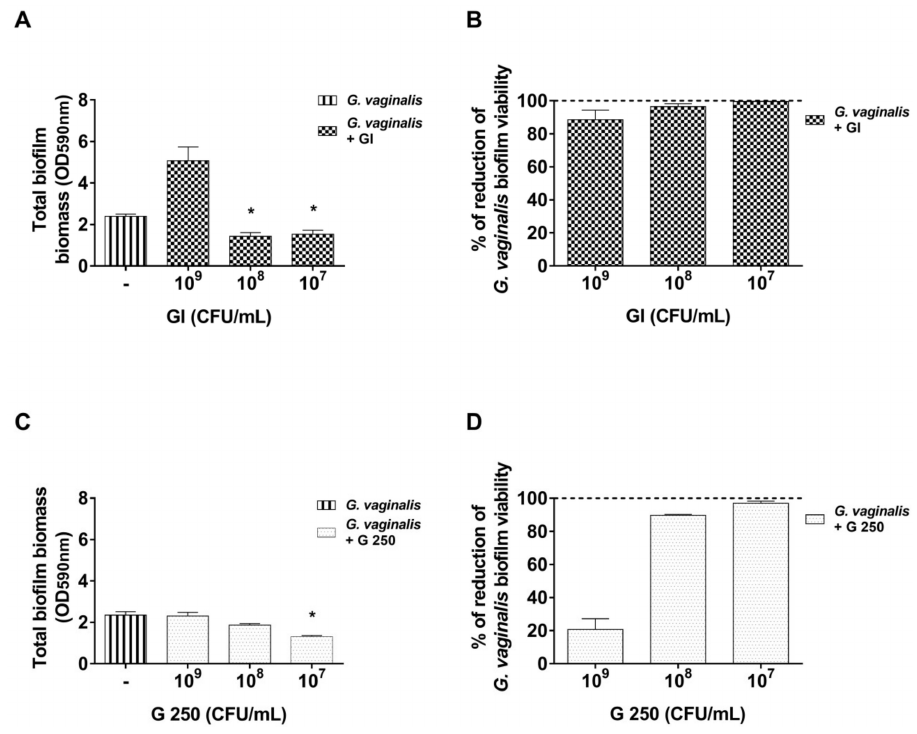
Figure 4. E ff ect of S. cerevisiae CNCM I-3856 (GI) and L. rhamnosus GG (G 250) on G.